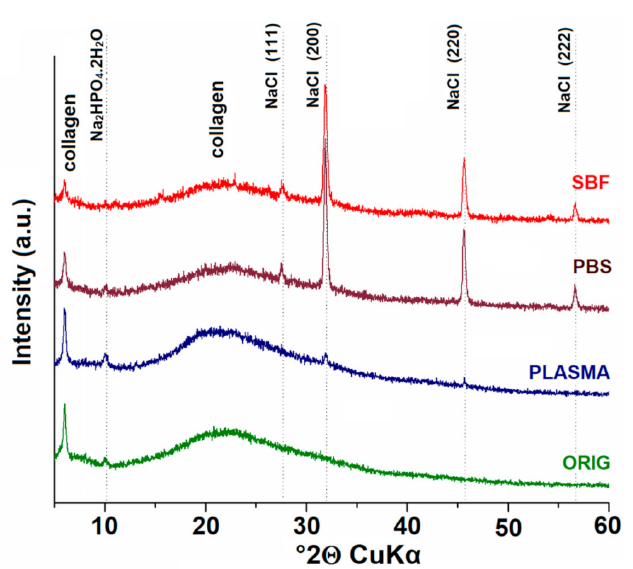
Figure 8. Comparison of the XRD patterns of the original collagen (ORIG) and the collagen exposed to all the studied media (PLASMA, PBS, and